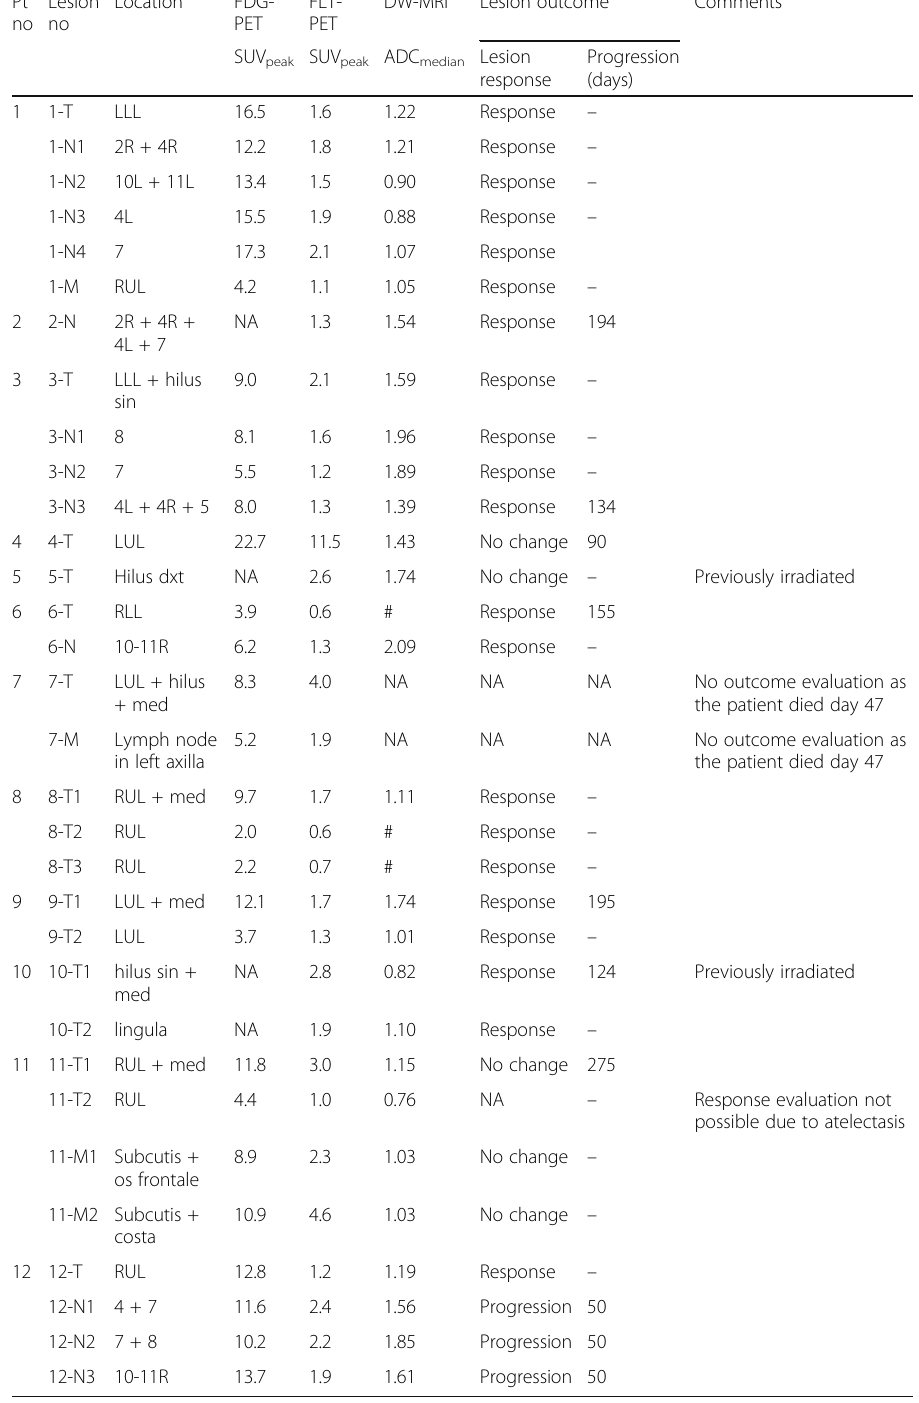
Table 2 Malignant lesions: location, FDG-SUV peak , FLT-SUV peak , ADC median , and outcome Pt Lesion Location FDG- FLT- DW-MRI Lesion no no PET PET